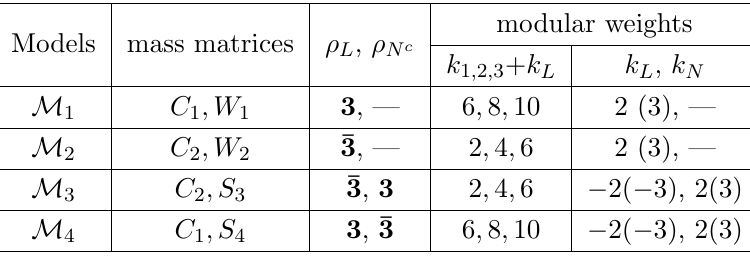
Table 4 . Summary of the \minimal" neutrino mass models with the (cid:0) 7 modular